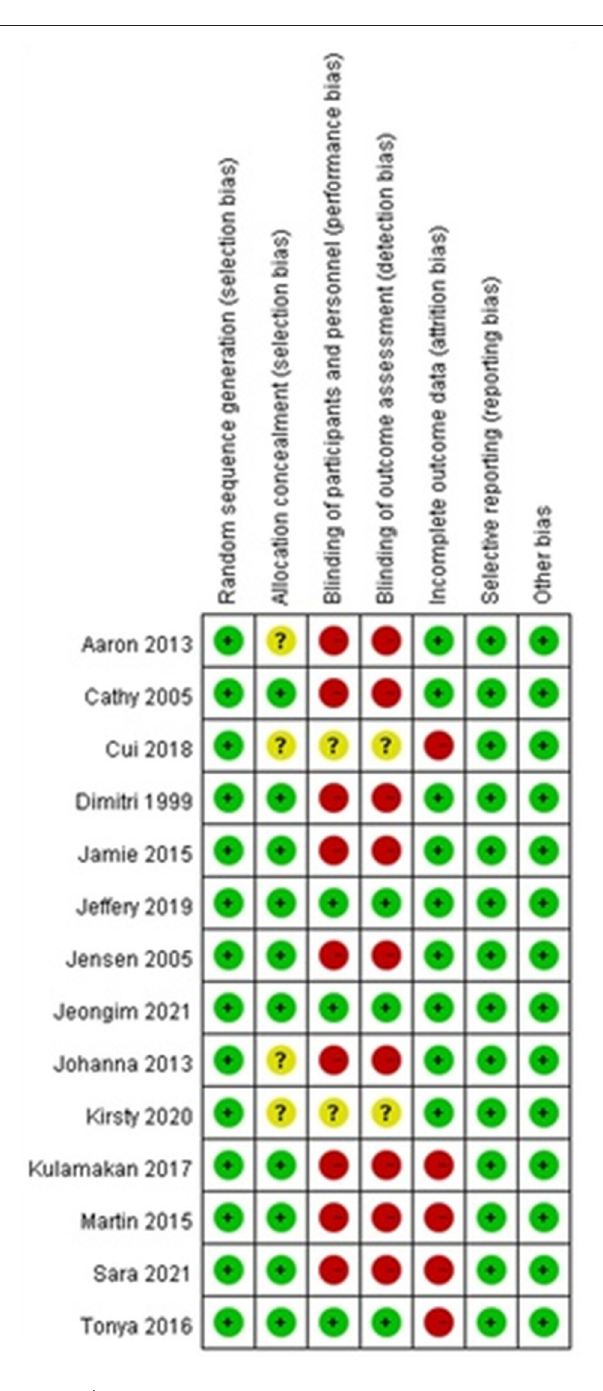
Genç and Öner (28) reported that participants receiving an integrated instructional video performed significantly better on transfer than the procedural-only video. Beattie et al. (29) reported that groups trained in 3D and tested in 3D demonstrated superior training performance and took fewer repetitions to reach proficiency than the group in